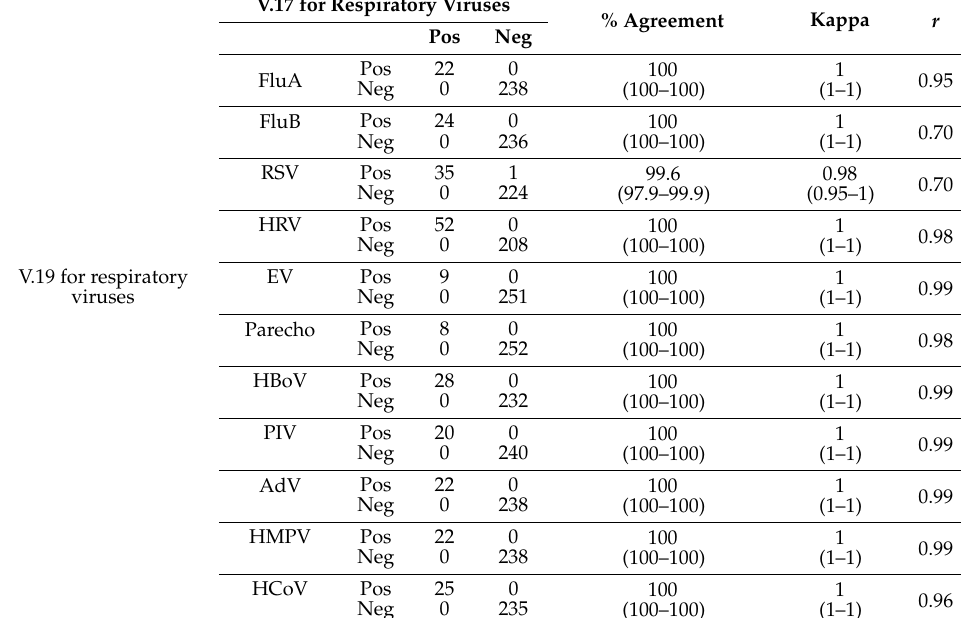
Table 1. Comparison of the Respiratory Viruses 16-Well Assay V.17 versus V.19 for respective